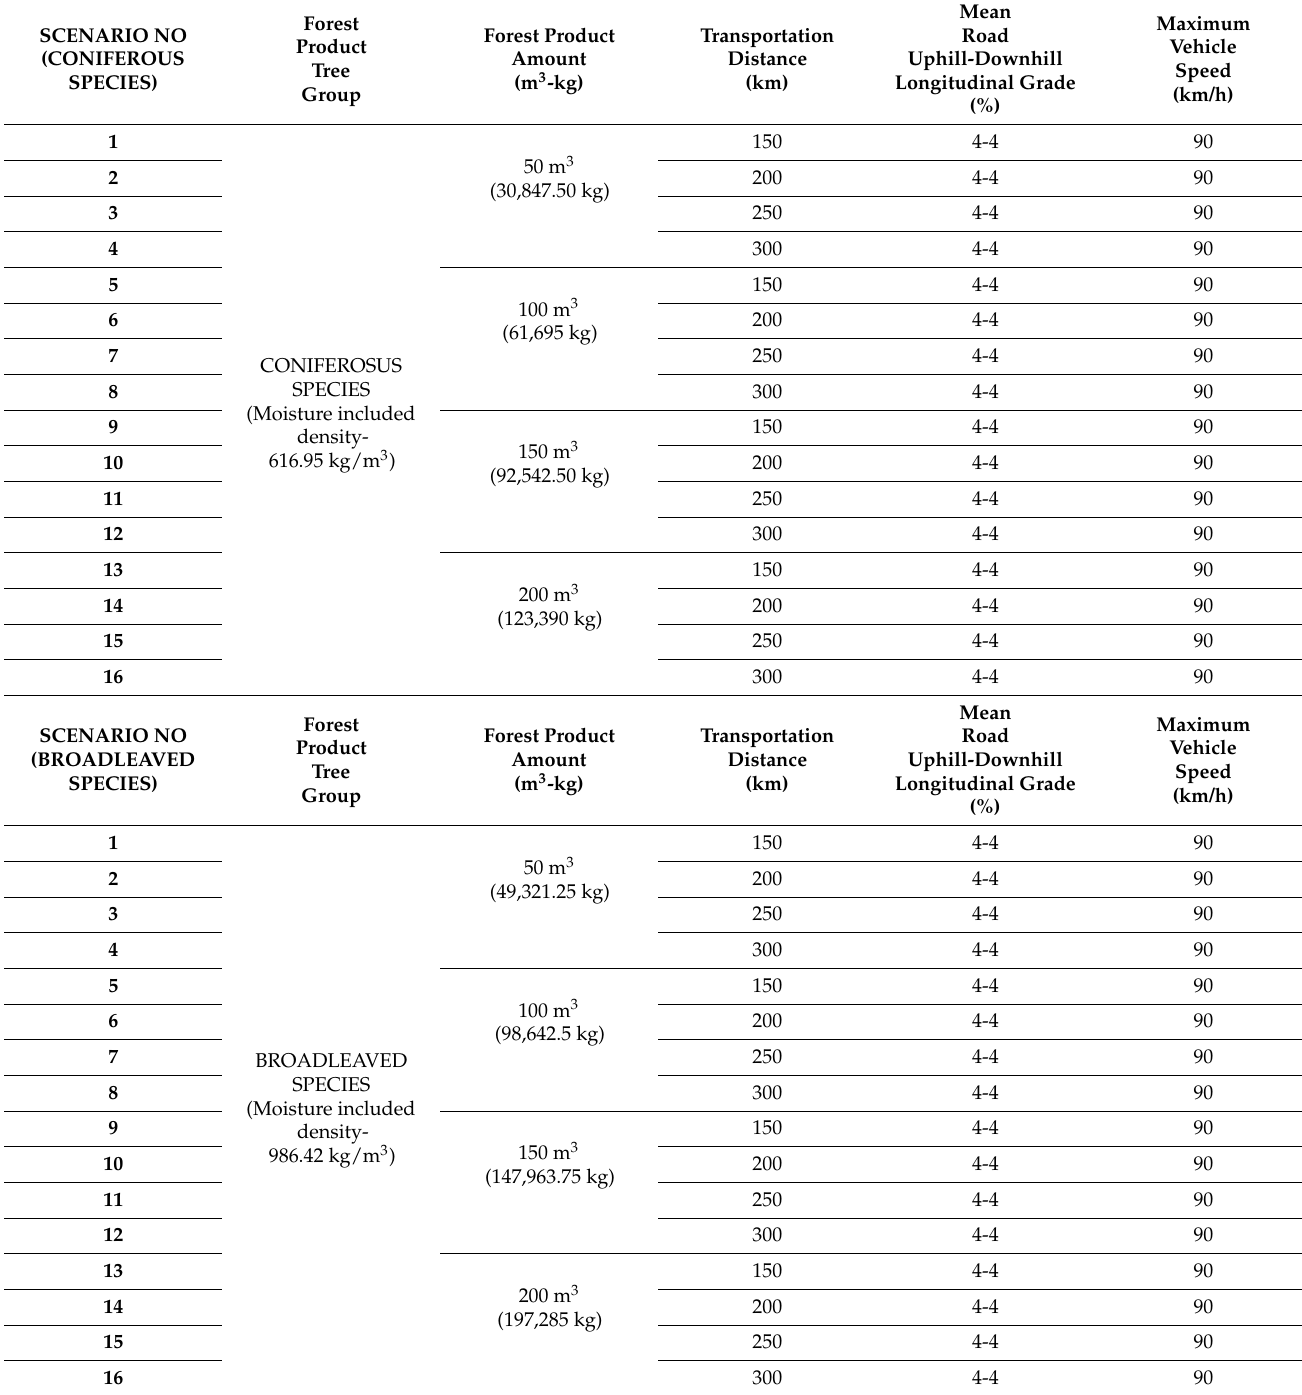
Table 14. Transportation scenarios for coniferous and broadleaved tree